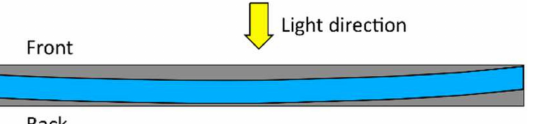
Figure 29. Schematic representation of the front surface and back surface of the beam, as well as the light direction. The beam shows a positive bending shape. Redrawn from reference